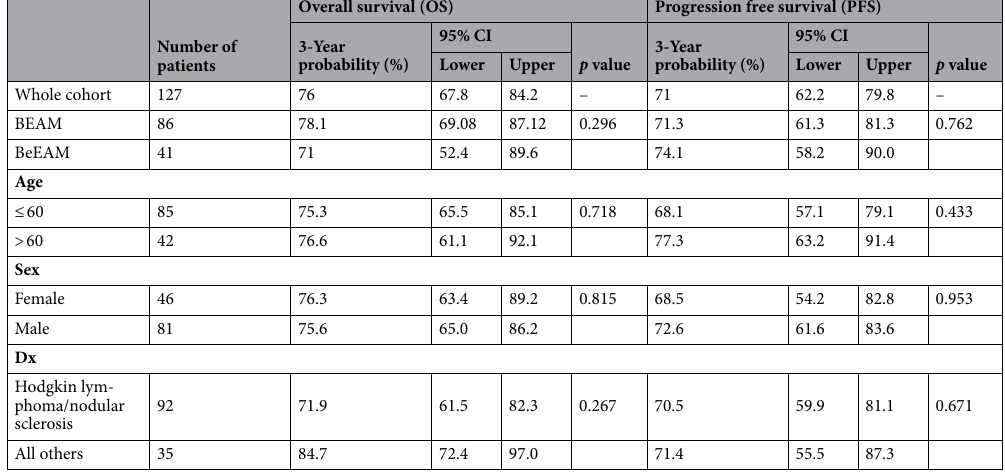
Table 3. Probability of 3-year survival.